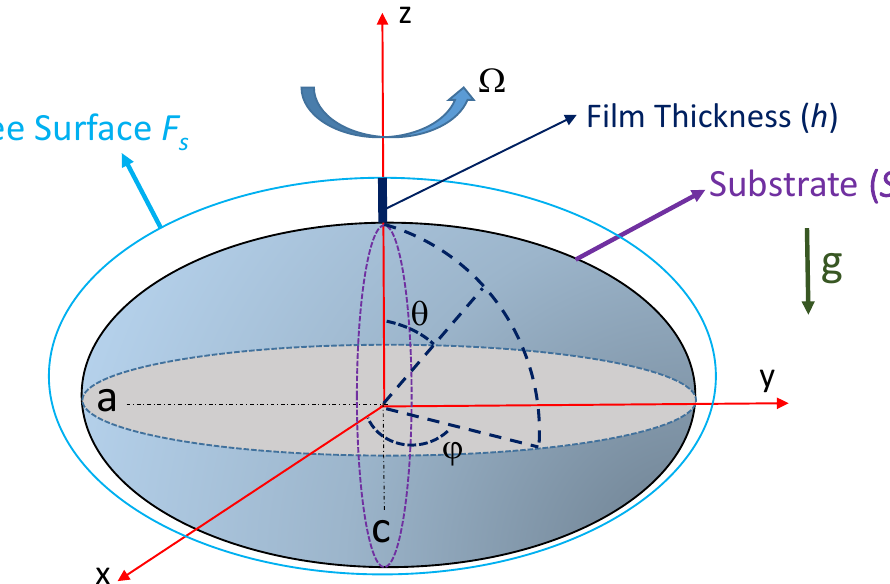
Figure 1. A schematic of the